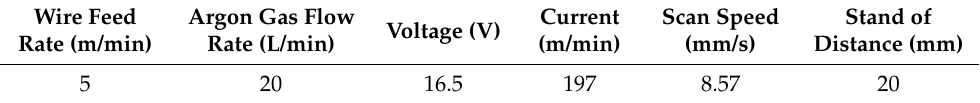
Table 2. Optimized parameters for the Wire Arc Additive Manufacturing (WAAM) deposition.